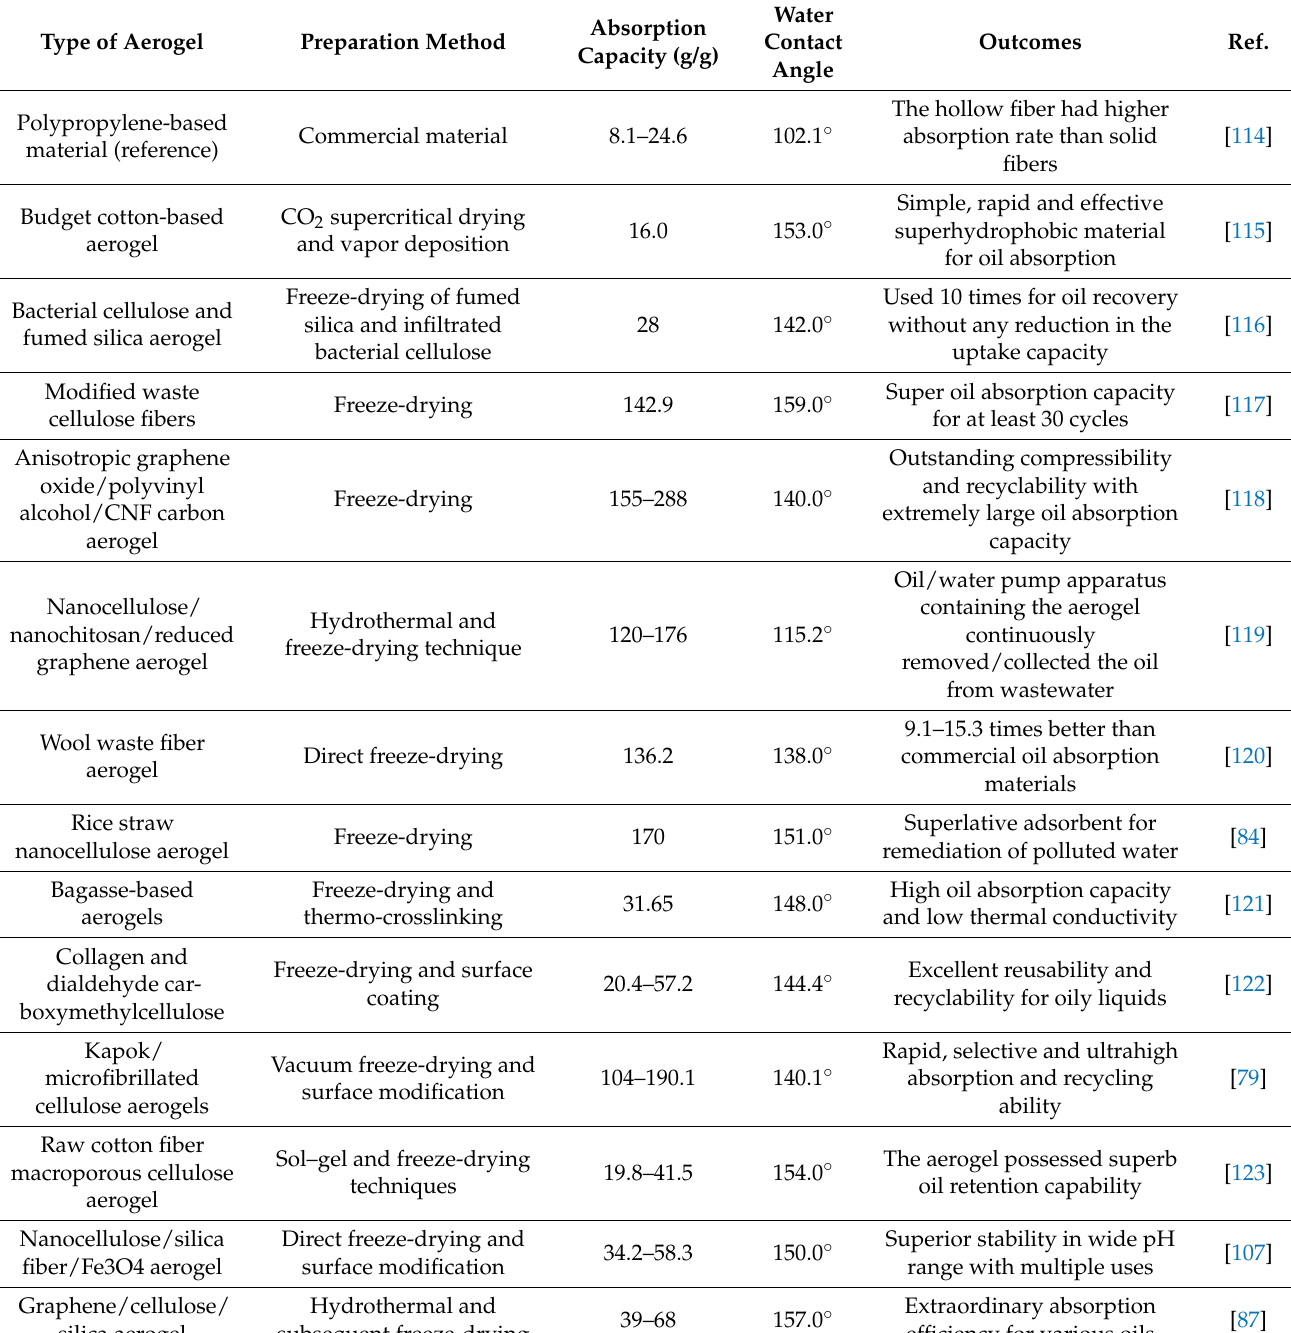
Table 3. Literature summary of nanocellulose-based aerogels for oil absorption